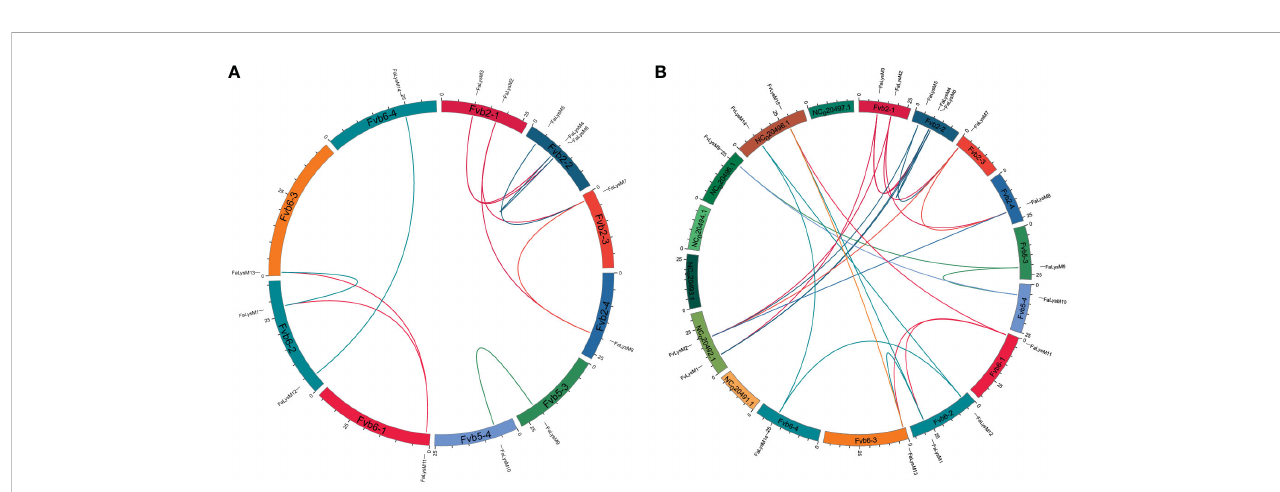
FIGURE 4 Collinearity analyses of FaLysM genes in the F. × ananassa genome, and between F. × ananassa and F. vesca . (A) Collinearity analysis of FaLysM genes in F. × ananassa ; (B) Interspeci fi c collinearity analysis of LysM genes between F. × ananassa and F. vesca ; Outer boxes represented chromosome numbers. Colored lines in boxes indicated the location of LysM genes in each chromosome. Gene pairs with a syntenic relationship are joined by colored lines.